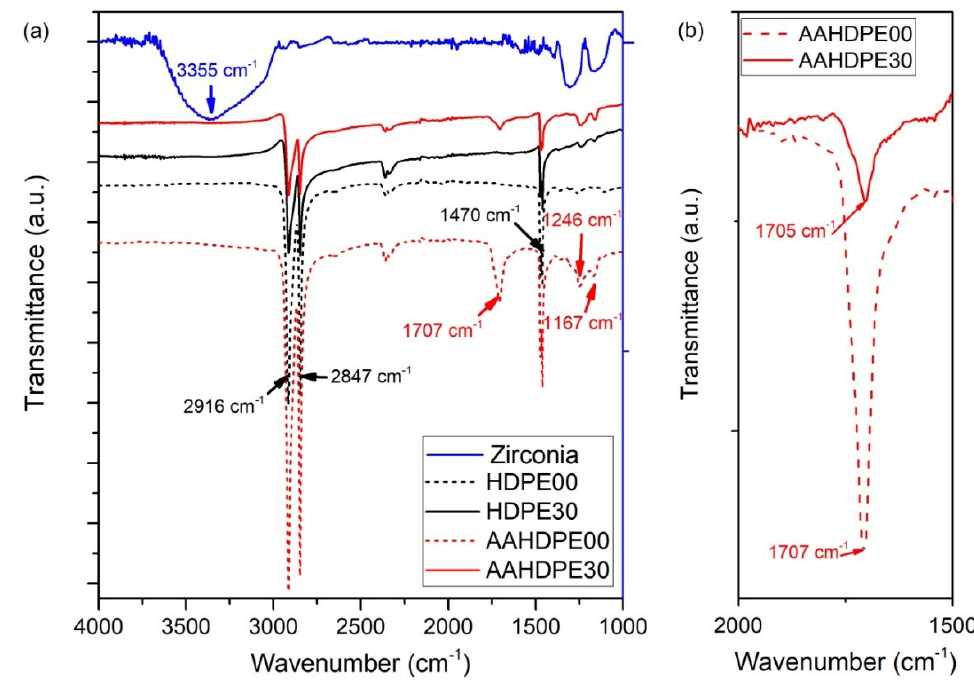
Figure 3. ( a ) Infrared absorption spectrum of the HDPE00, HDPE30, AAHDPE00 and AAHDPE30 with the main peaks of the pure components in di ff erent colors; ( b ) Magnification of the infrared absorption spectrum for the AAHDPE00 and AAHDPE30 in the 2000–1500 cm -1 range with the carboxyl peak for the polymer and the